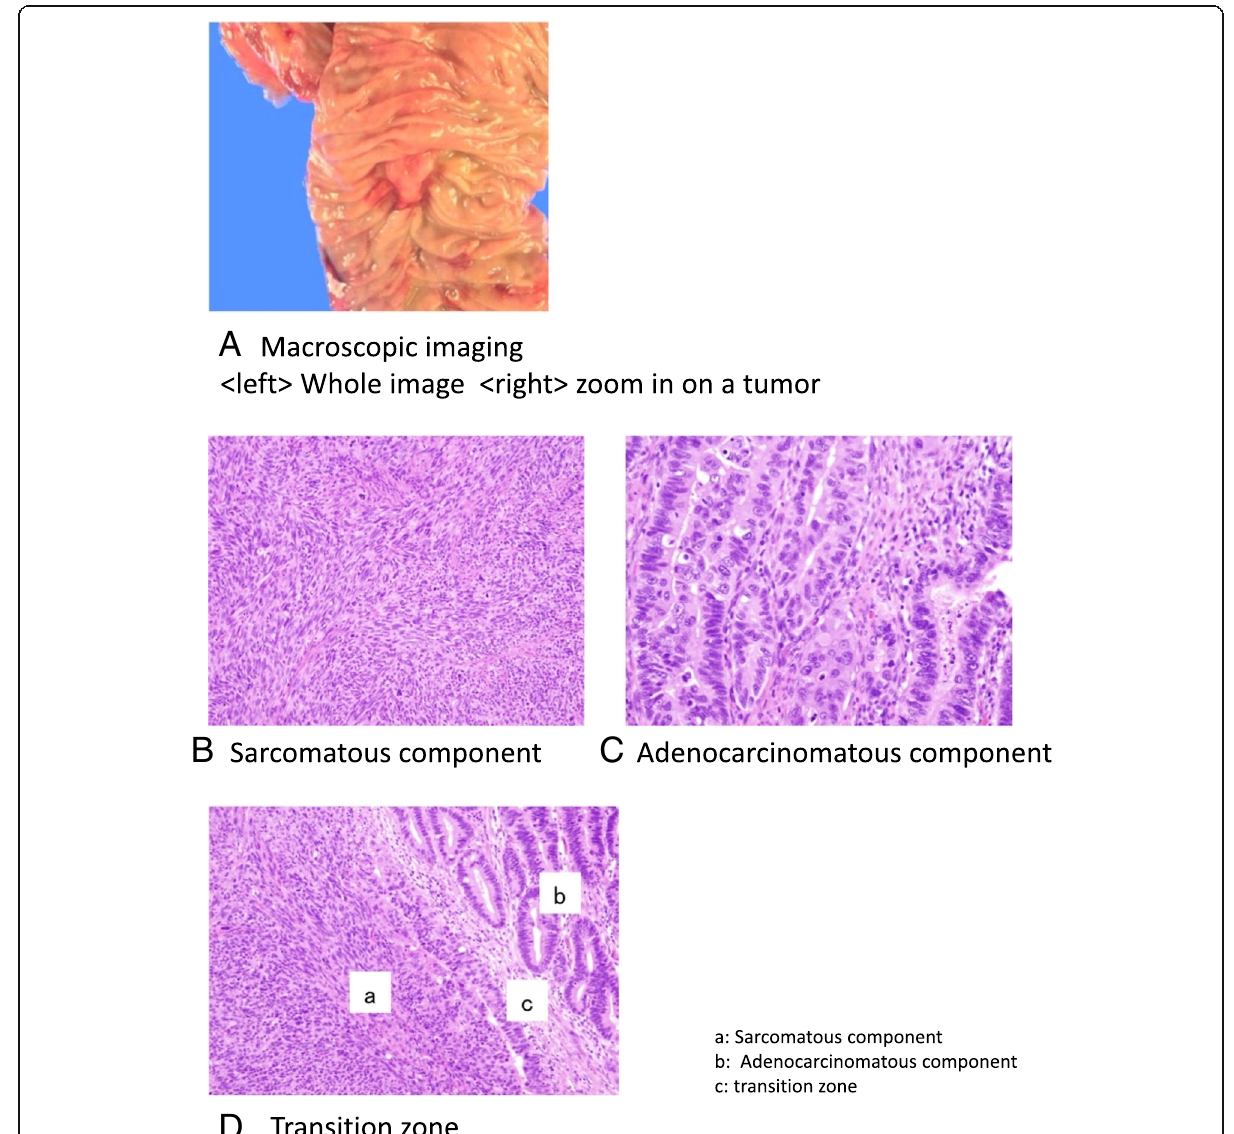
Fig. 3 Pathological findings. Macroscopically, a 2.0×1.4 cm elastic hard tumor was found at Vater ’ s papilla ( A ). The microscopic examination of the specimen showed that spindle cells, which constructed sarcomatous tissue proliferated with intricate infiltration ( B ) and growth of tubular adenocarcinoma ( C ). Two components existed across the transition zone ( D ). a, sarcomatous component; b, adenocarcinomatous component; c, transition